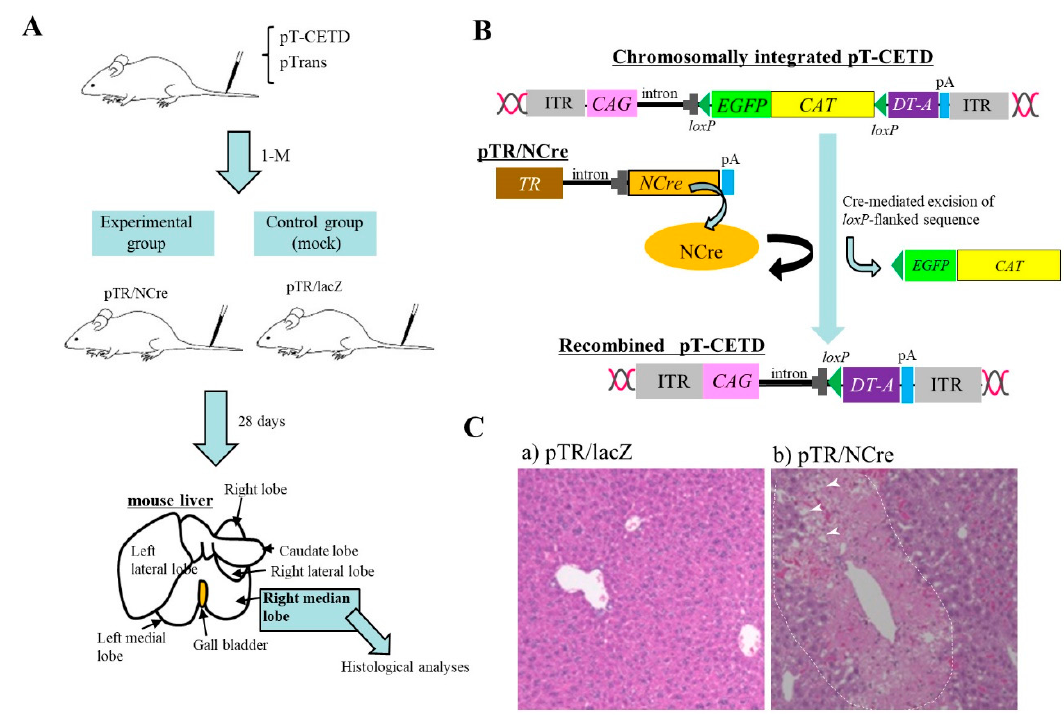
Figure 2. Hydrodynamics-based gene delivery (HGD) and piggy Bac (PB) transposon system enable long-term gene expression in murine liver, according to the article by Nakamura et al. [43]. ( A ) Schematic representation of experimental outline. At first, PB transposon (pT-CETD) and PB transposase expression plasmid (pTrans) are co-injected into adult ICR male mice via the tail vein by HGD to perform chromosomal integration of CETD component in hepatocytes. One month later, these mice are intravenously injected with pTR/NCre (shown in B ) or pTR/lacZ (mock). At 28 days after gene delivery, the right median lobe of liver is dissected for histological analysis. ( B ) Schematic representation of conditional ablation of murine hepatocytes by Cre/ loxP system. When mice are subjected to HGD with a solution containing pT-CETD and pTrans, chromosomal integration of pT-CETD is thought to occur in some hepatocytes (upper panel). Addition of pTR/NCre to these mice via HGD will elicit the generation of recombined pT-CETD, which in turn generates a toxic protein diphtheria toxin-A chain (DT-A) (lower panel). ( C ) Pathological analysis of pT-CETD-incorporated males assayed 28 days after the second HGD with pTR/lacZ (a) or pTR/NCre (b). Note the presence of focal necrosis (arrowheads in (b); probably caused by conditional expression of DT-A) in an area enclosed by dotted lines. Abbreviations are ITR, inverted terminal repeat; CAG, chicken β -actin-based promoter; EGFP, enhanced green fluorescent protein cDNA; CAT, chloramphenicol acetyltransferase gene; lacZ, gene coding for β -galactosidase; pA, poly(A) sites; TR, transthyretin promoter; NCre, gene coding for Cre with nuclear localization signal.